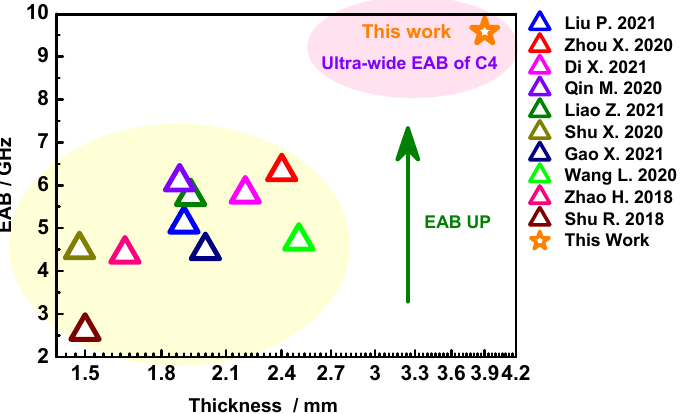
Figure 11. Microwave absorbing performance between as-prepared C4 and other composites reported in literatures.